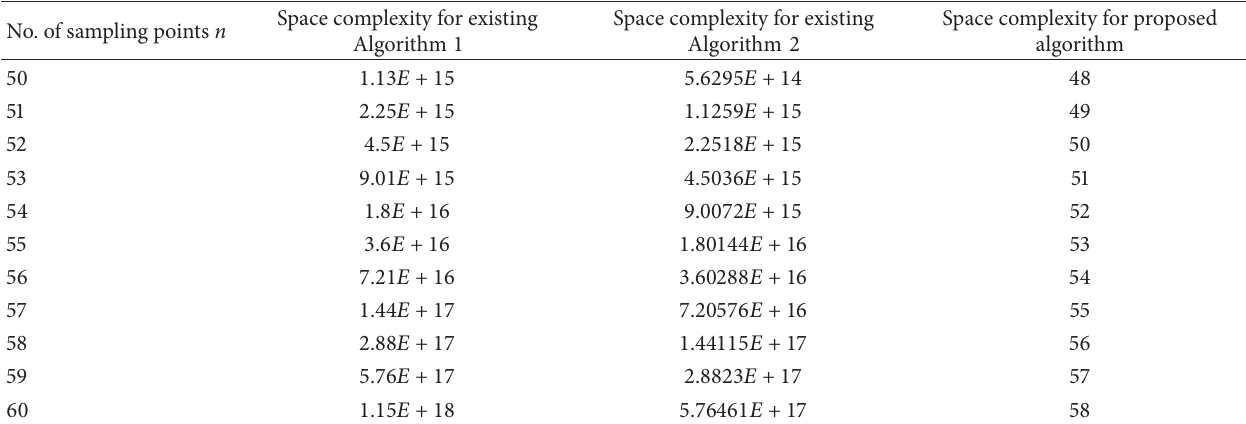
Table 4: Comparison among existing Algorithm 1, existing Algorithm 2, and proposed algorithm in terms of space complexity considering 𝑚 = 1 , 𝑘 = 2 , and 𝑘 󸀠 = 1 .